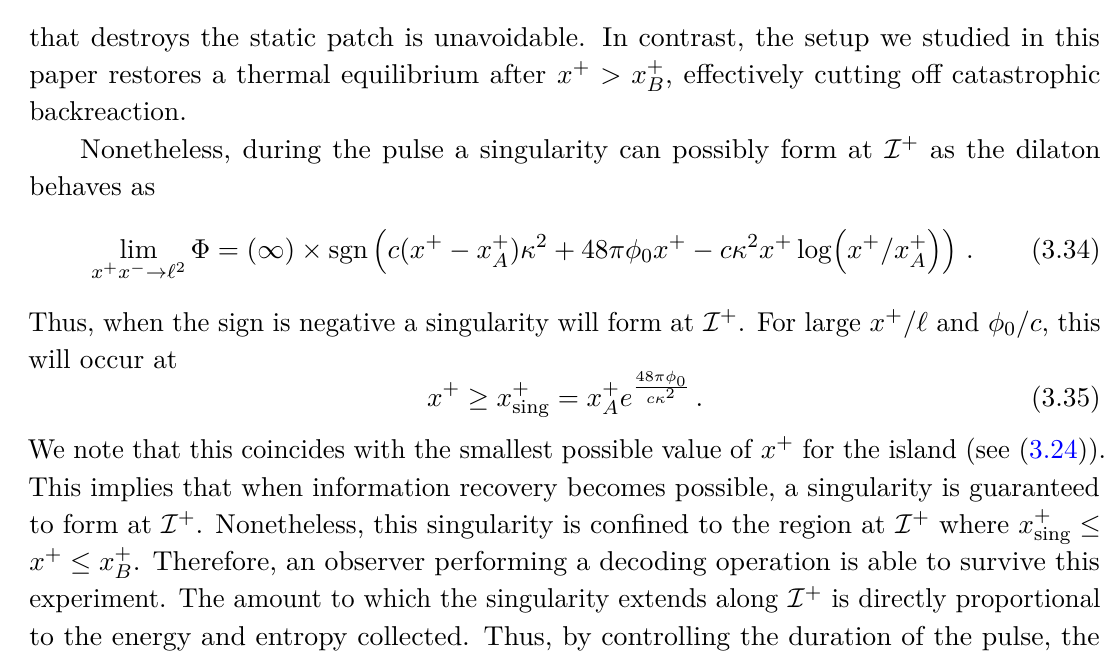
Figure 7 . Behavior of the entropy S ( R R ) in the scenario where a pulse is applied during the time t A ≤ t r ≤ t B after the saturation time is reached. The highest plateau corresponds to the de Sitter entropy S dS = 2 π (Φ 0 + Φ) x − =0 κ 2